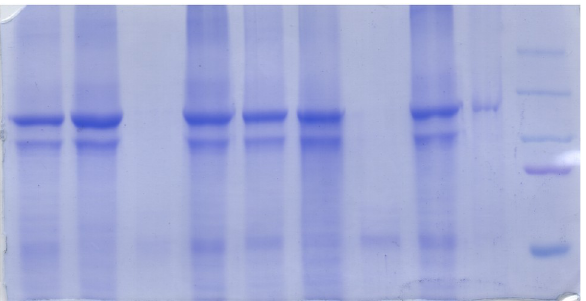
Fig 6. A. Effect of limited proteolysis on the ATPase activity of Spf1p. 4 μ g of Spf1p from detergent-lipid micelles was digested for 30 min at 28˚C with different amounts of the protease indicated in the figure. The chymotrypsin and trypsin digestions were stopped by the addition of 20 μ g aprotinin, and proteinase K and V8 digestions were stopped by the addition of 0.5 mM PMSF. The ATPase activity was measured as described under “Materials and methods”. B. 10 μ g of Spf1p in detergent micelles was exposed to chymotrypsin for different times, either in the absence (-L) or in the presence (+L) of PC. The proteolysis was ended by the addition of aprotinin and after the addition of PC to (-L) samples, the ATPase activity was measured. C. The Chy1 fragment does not dissociates from the micelle after proteolysis. 20 μ g of Spf1p in detergent micelles was exposed to chymotrypsin for 5 min, either in the absence (-L) or in the presence (+L) of PC. After stopping the reaction an aliquot of the proteolyzed sample was saved (P), and the rest was incubated with 50 μ l of Ni-NTA agarose, washed three times with 1 ml of solution containing 0, 25 and 50 mM imidazole and finally eluted with 1 ml of 500 mM imidazole. The protein from 100 μ l of each step was precipitated with TCA, separated by SDS-PAGE and stained with Coomasie blue. P , proteolyzed sample before incubation with Ni-NTA resin, FT , supernatant containing part of the sample that did not bound to the Ni-NTA resin after the incubation, W , final wash with 50 mM imidazole, E , eluate of 500 mM imidazole. C , control of undigested Spf1p (0.75 μ g), M , molecular weight